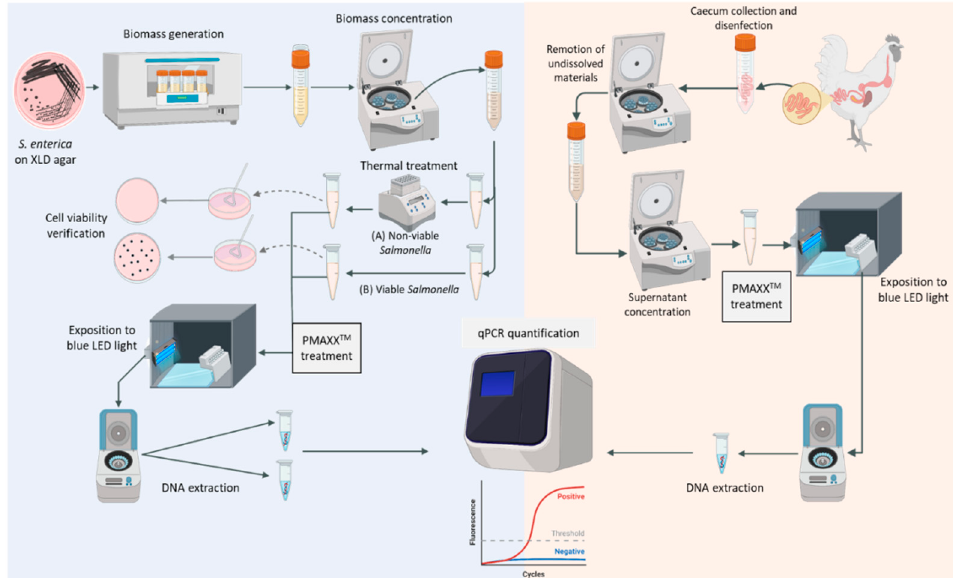
Figure 1. Flowchart of the Salmonella cultivation, thermal shock, PMAxx TM treatment, cell viability verification, and qPCR estimation (left-hand side). Flowchart of caecal collection and further analyses (right-hand side). Image generated with Biorender (https://biorender.com/) (accessed on 7 June 2022-Agreement N° KH24938MG0).